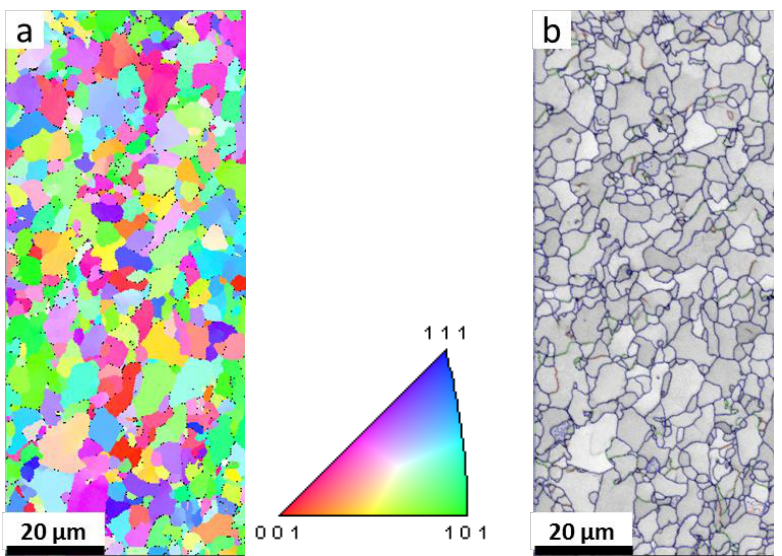
Figure 1. EBSD measurements of G20 steel: ( a ) inverse pole figure map; ( b ) grain boundary map.